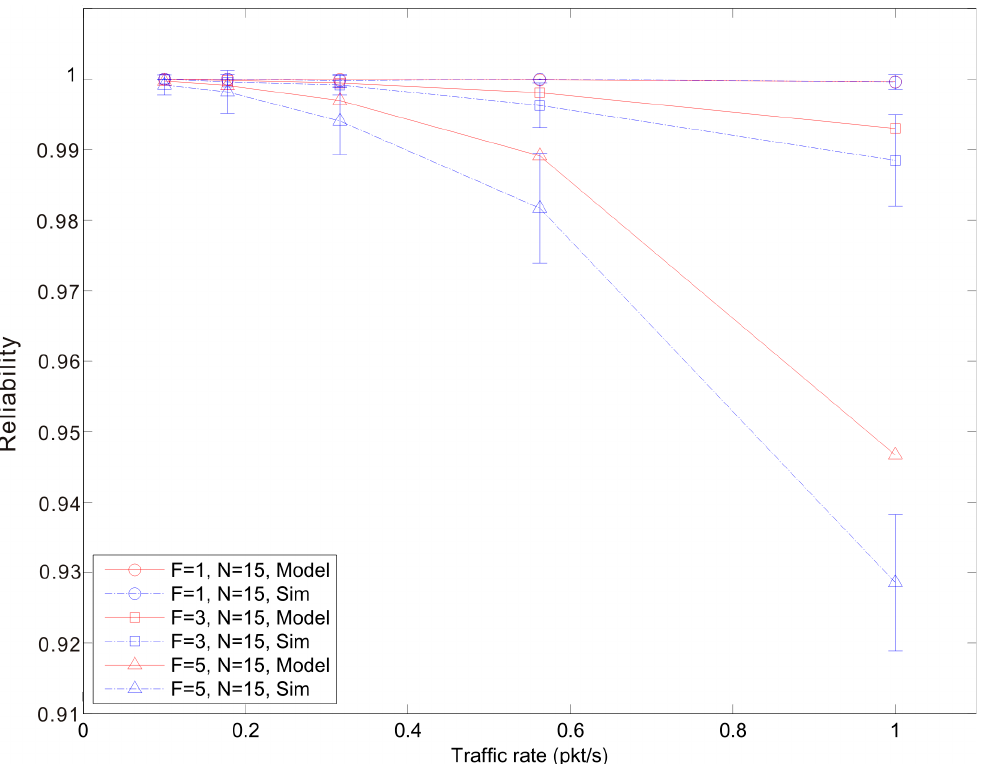
Figure 11. 6LoWPAN fragmentation reliability versus traffic rate for a star topology network composed by 15